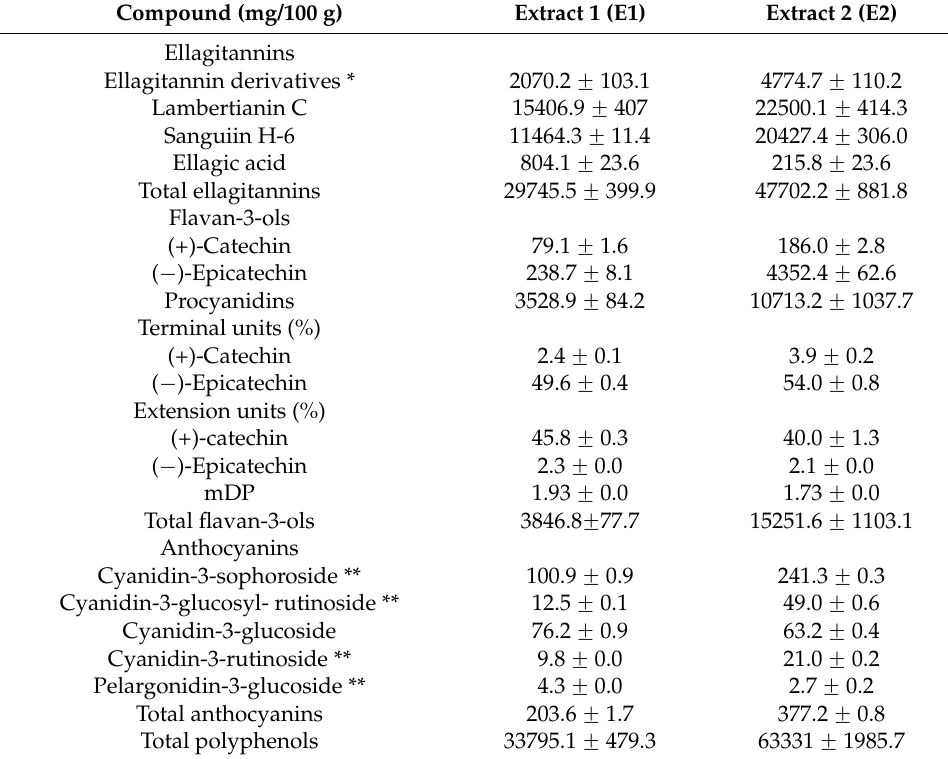
Table 5. Phenolic fractions of raspberry